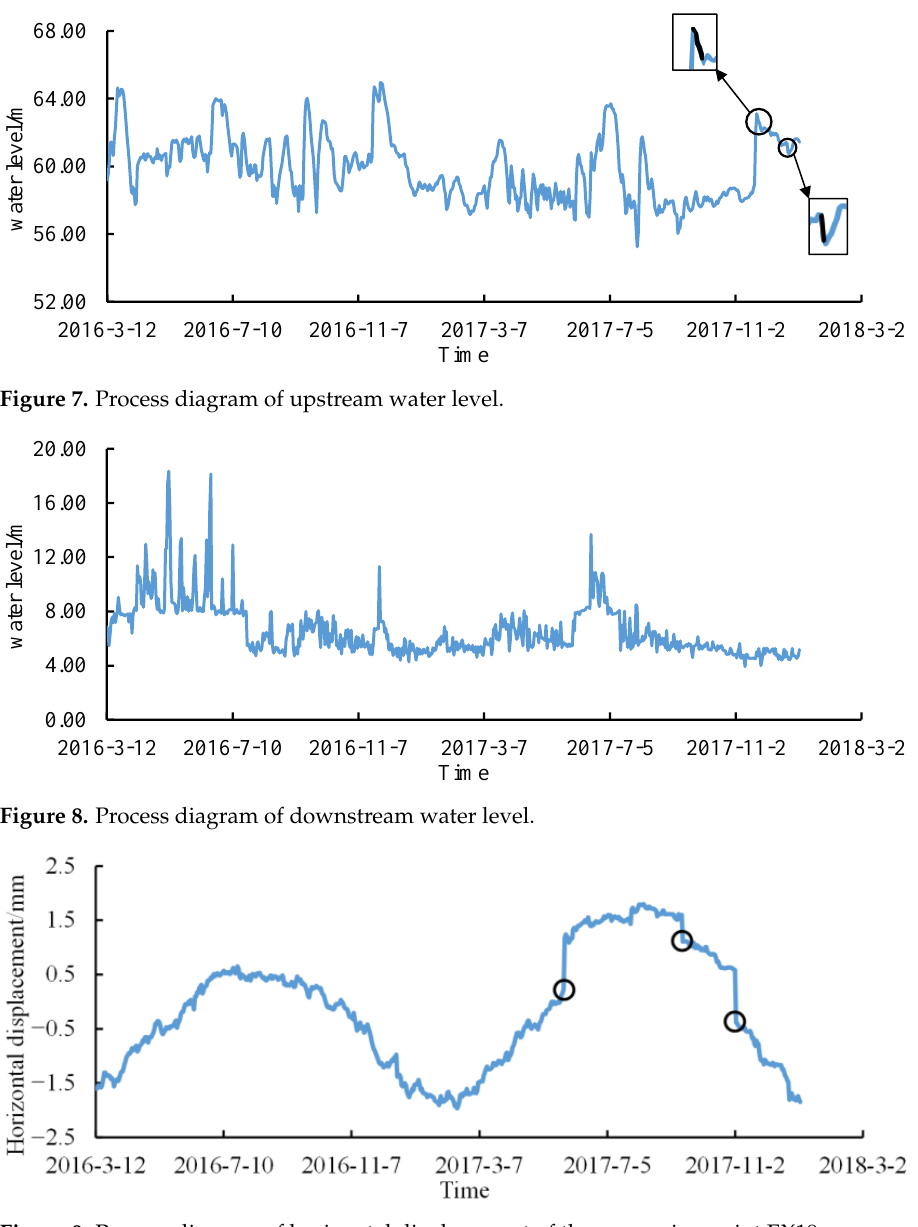
Figure 9. Process diagram of horizontal displacement of the measuring point EX19.